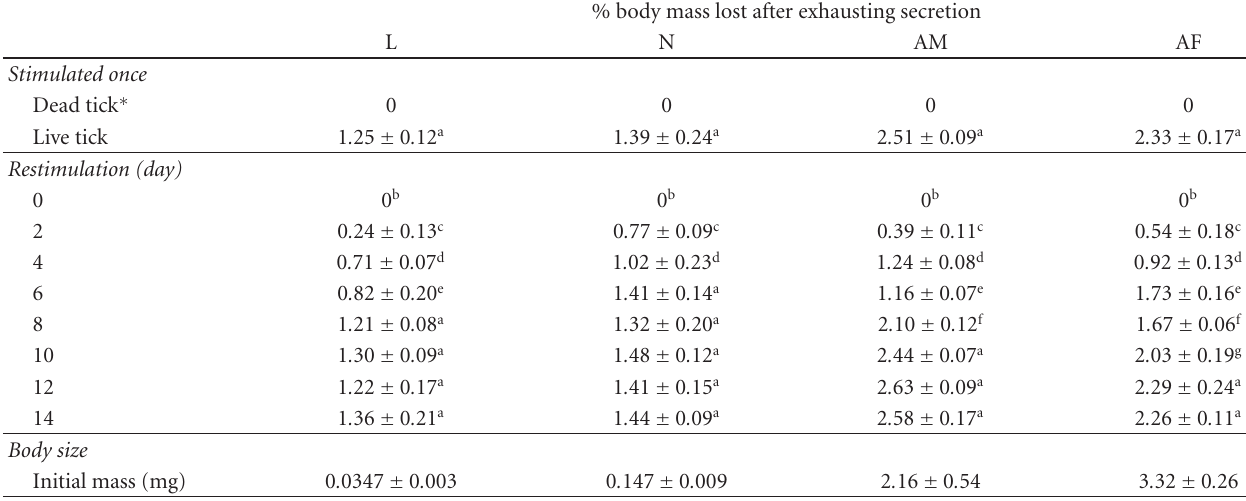
Table 1: Number of days required for the large wax glands to replenish secretion by di ff erent nonfed stages of R. sanguineus (93% RH, 25 ◦ C) based on restimulation (leg pinching) following initial exhaustion of secretory reserves. L, larva; N, nymph; AM, adult male; AF adult female; dead tick, killed by freezing and then thawed to room temperature (shown); ∗ , results from HCN-killed were similar. Data are mean + SE and values followed by the same superscript letter within a column are not significantly di ff erent (ANOVA; P < . 05). (N = 3 replicates of 10 ticks for each time point with each replicate coming from a separate rearing batch of